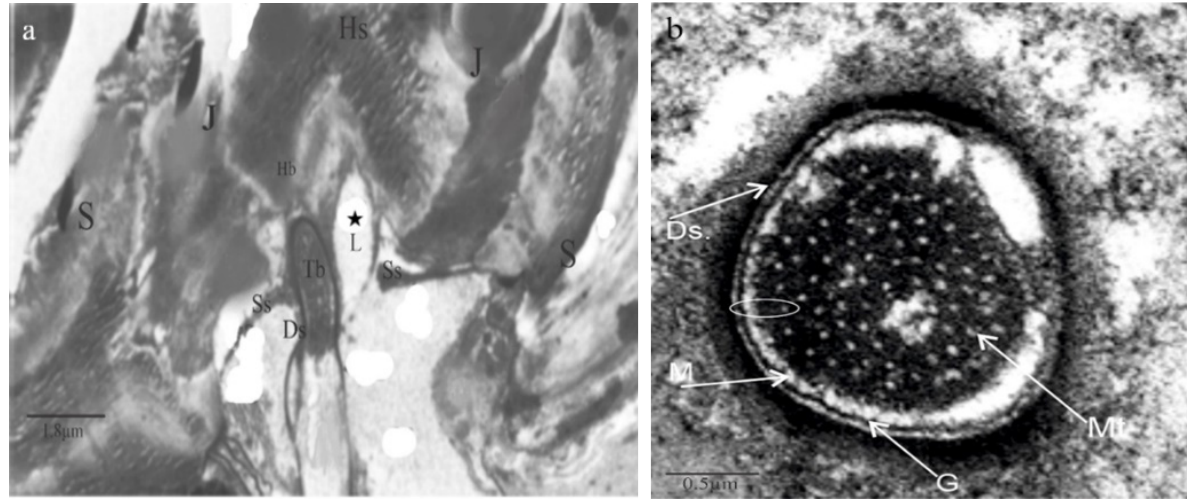
Figure 3. Transmission electron micrographs of the ultra-microstructure of trichoid sensilla in Nabis rugosus . ( a ) Sensing plane with the base of the Ts, with the connection of the dendrite sheath to the hair base with the dendritic segment surrounded by the lymph space L indicated by *, thecogen, trichogen, and tormogen cells. ( b ) Cross-sections of the trichoid sensilla dendrite with dendrite sheath and microtubules separated by the membrane and granules along with EDM (electron-dense material)—dark area is EDM. Hs: hair shaft, J: joint membrane, Tb: Tubular body, S: socket, Ds: Dendrite sheath, Ss: socket septum, G: granules, M: membrane, Mt: microtubules.